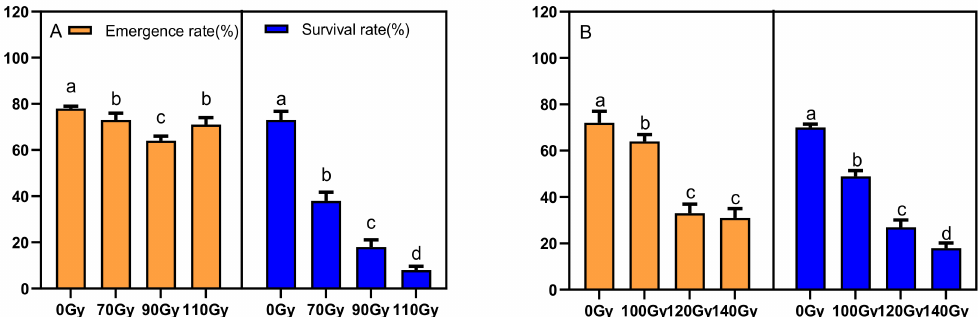
Figure 1. Effects of 12 C 6+ carbon ion beam irradiation on emergence rate and survival rate in the M 1 generation. Means with different letters are significantly different at p ≤ 0.05. ( A ) The emergence rate and survival rate of different irradiation doses in 2017. ( B ) The emergence rate and survival rate of different irradiation doses in